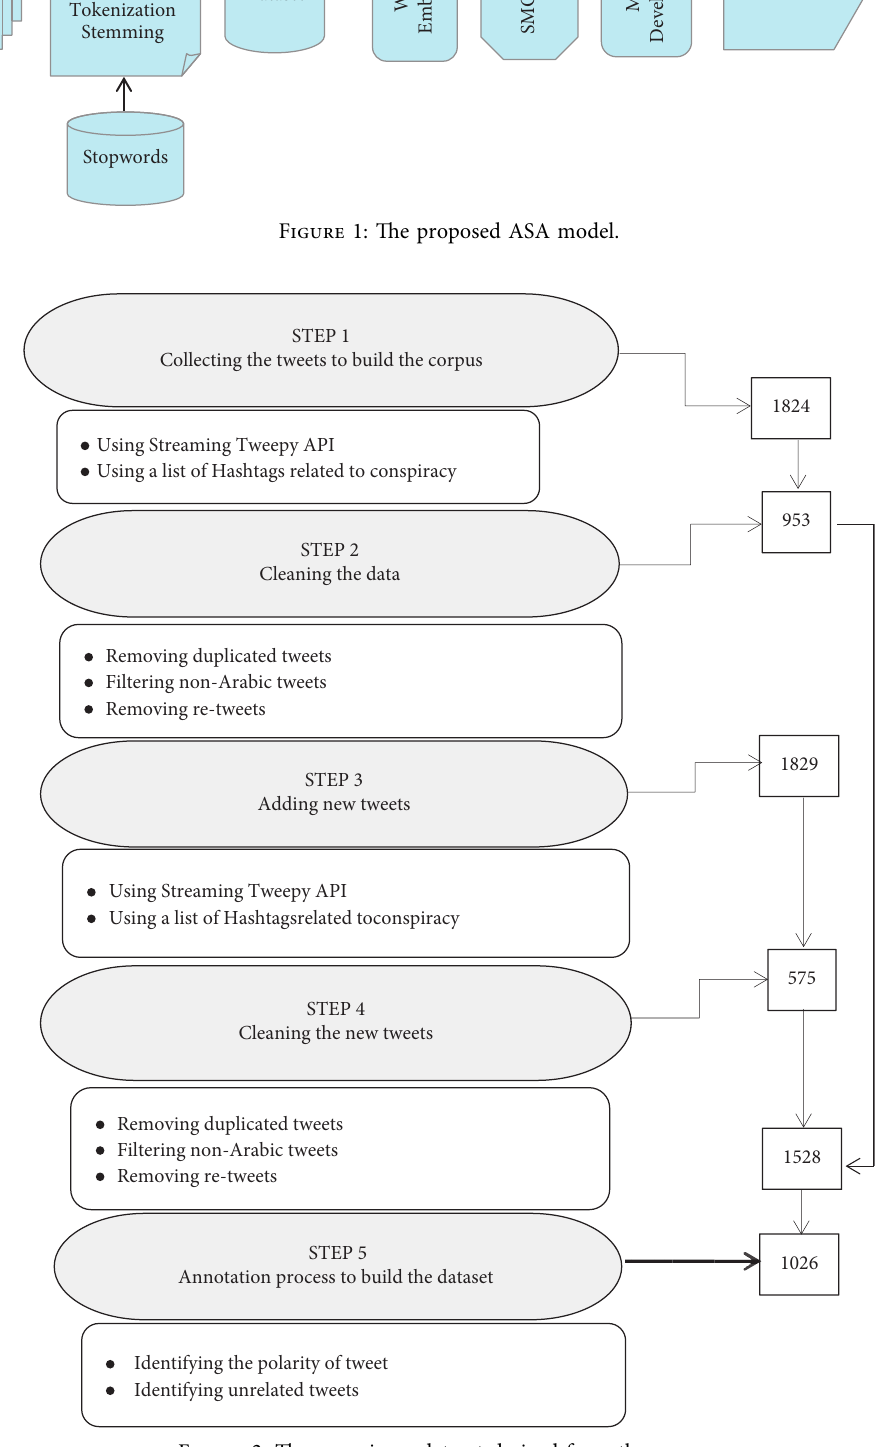
Figure 2: The conspiracy dataset derived from the